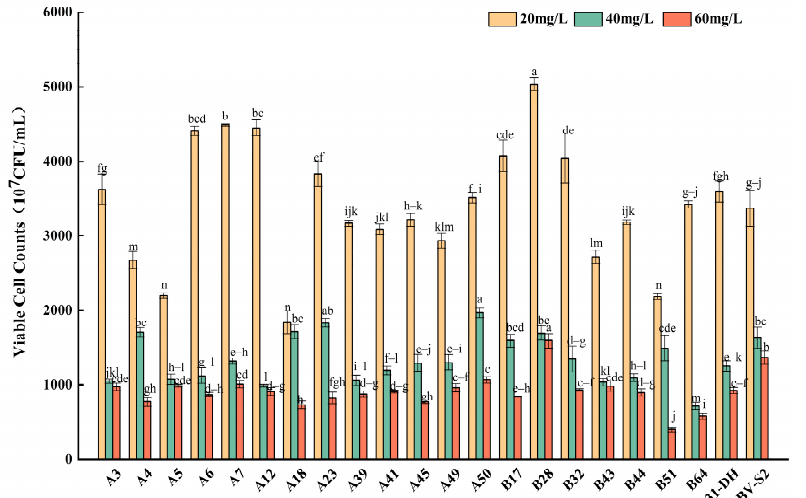
Figure 4. Growth of twenty L. plantarum and control strains in MRS-AJ, which contained 20, 40, and 60 mg/L SO 2 , respectively. Different small letters indicate significant differences according to the LSD Fisher test ( p <